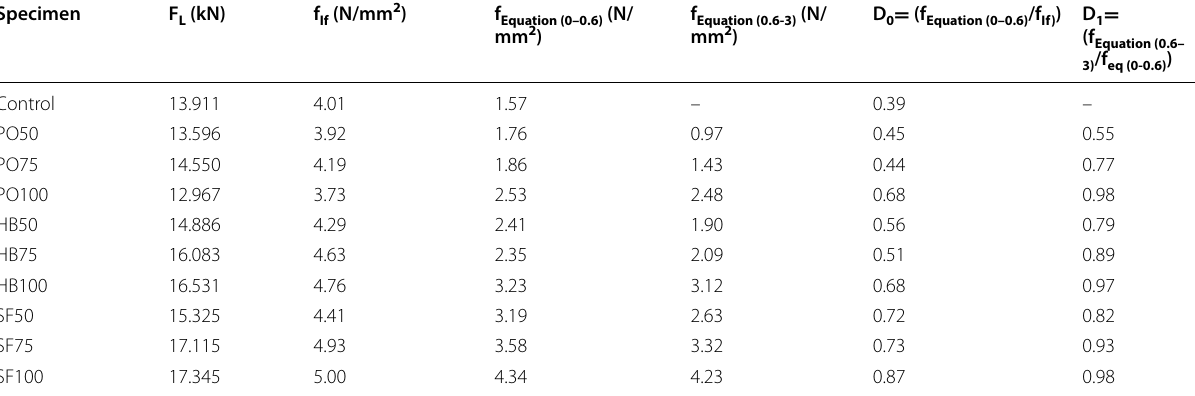
Table 4 Average equivalent flexural strength calculation for all specimens.